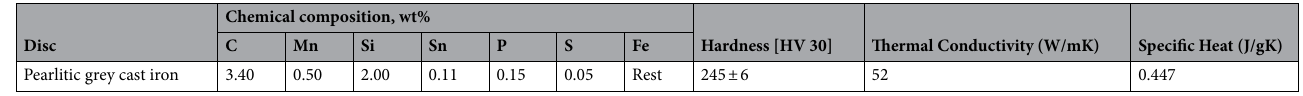
Table 2. Composition and properties of the pearlitic grey cast iron counterface 18